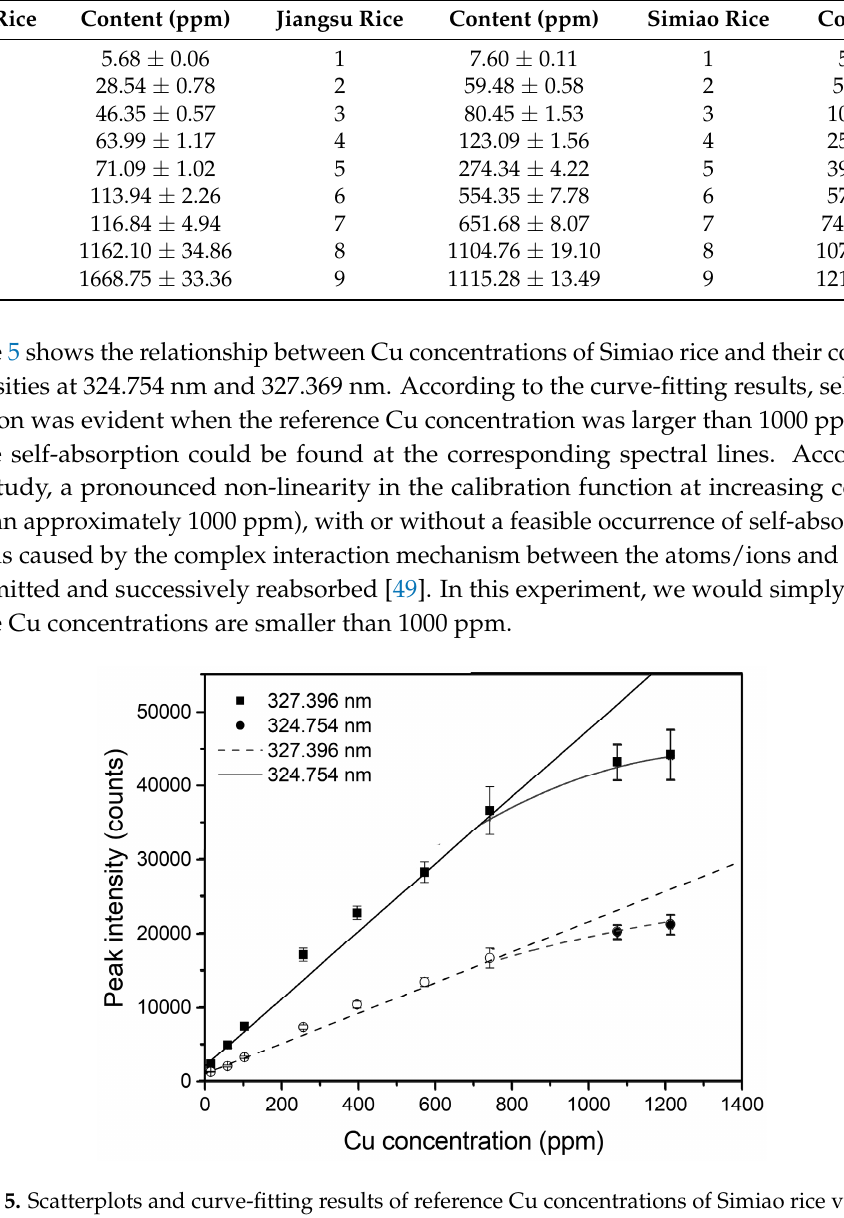
Table 1. Reference values of Cu concentrations and uncertainties detected by FAAS